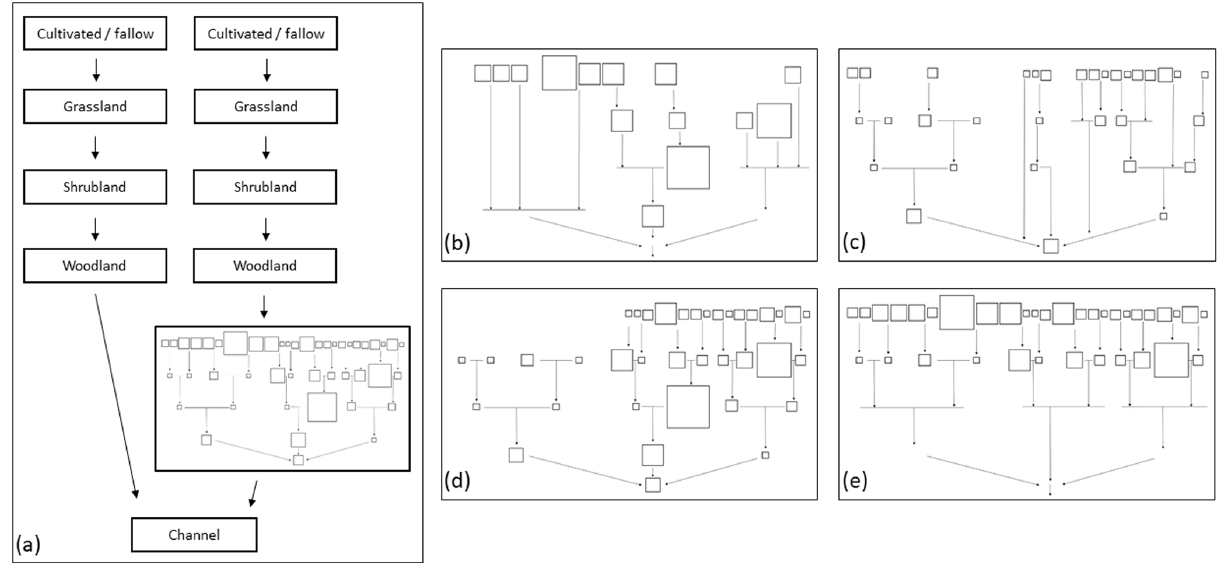
Figure 2. Panel (a) illustrates the runoff routing among the HRUs showing the non-wetland and wetland catenas, where the latter includes routing runoff from the non-contributing portion of the basin through a wetland complex. The relative sizes and locations of the wetlands in this complex are conveyed by the squares in panel (a) . Panels (b) through (e) illustrate an example of the complex under a 30% drainage scenario (the removal of 30% of wetland area), which would be substituted into the wetland catena in panel (a) . Panel (b) is the small-to-large scenario, panel (c) is the large to small, panel (d) is the top to bottom, and panel (e) is the bottom to top.